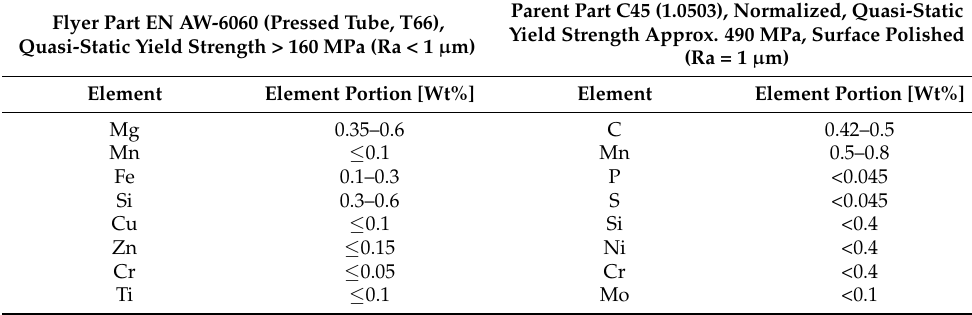
Table 3. Aluminum EN AW-6060 alloy composition [19] and steel C45 (1.0503) alloy composition